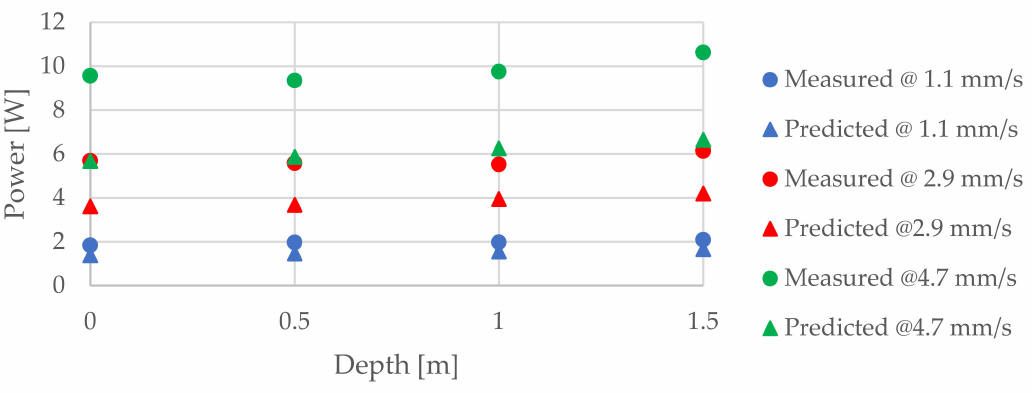
Figure 20. Power measurements at different depths when extending: comparison between measured and predicted values.